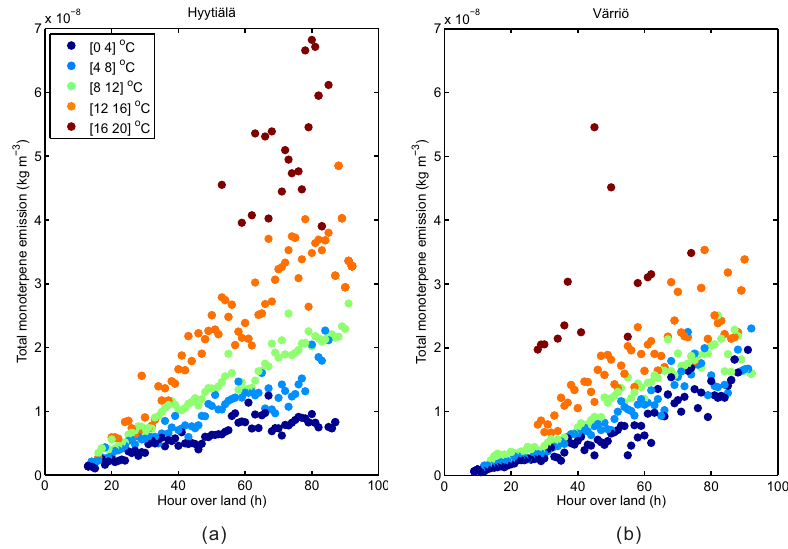
Figure 3. Accumulated total monoterpene emissions as a function of hour over land (a) at the SMEAR II station, and (b) at the SMEAR I station. The marker colours of legends represent the same binned temperature in both